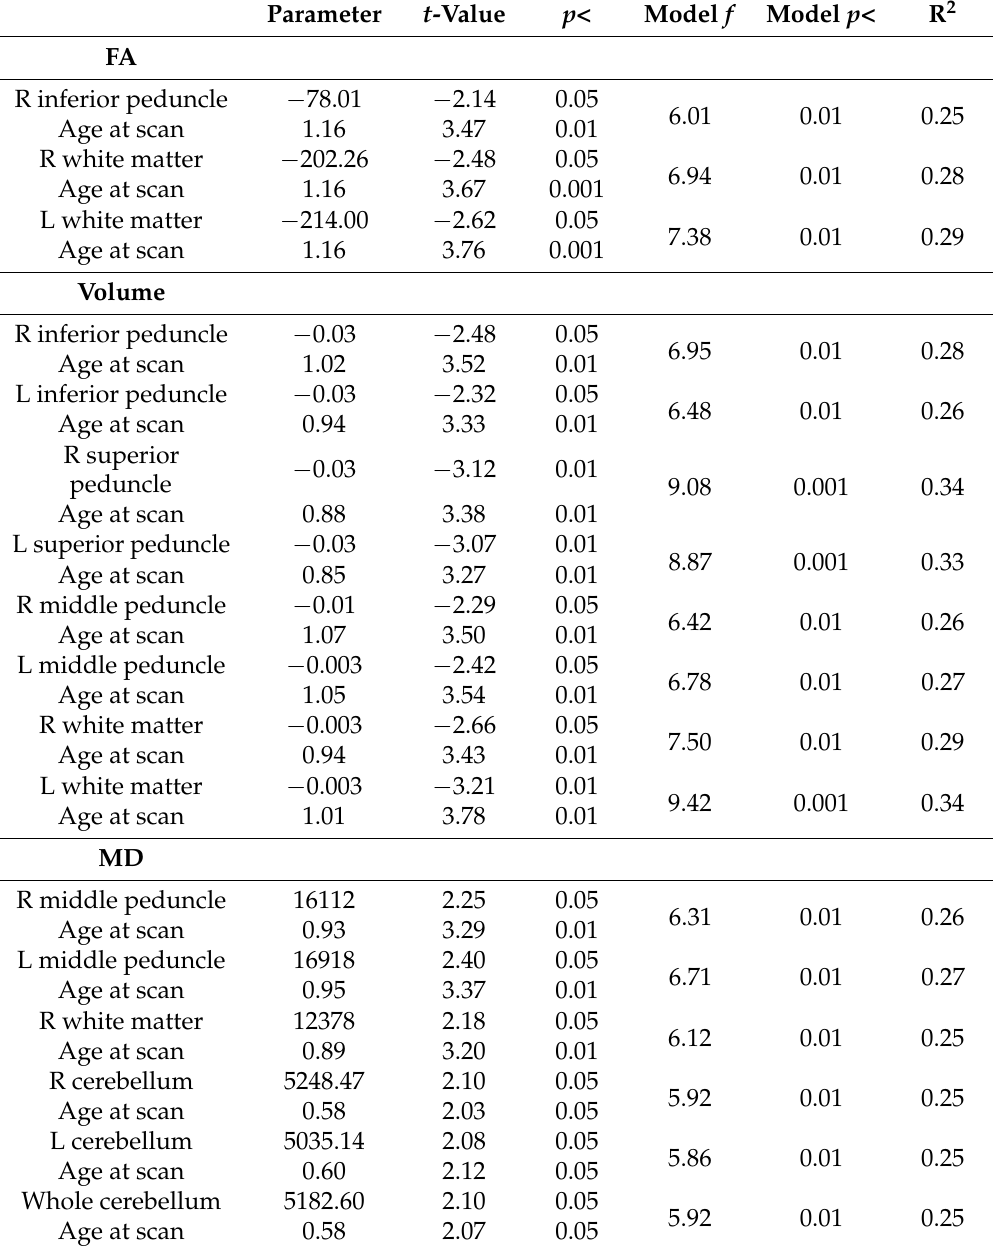
Table 5. Multiple Regression of NNSS on Cerebellar Measures and Age at